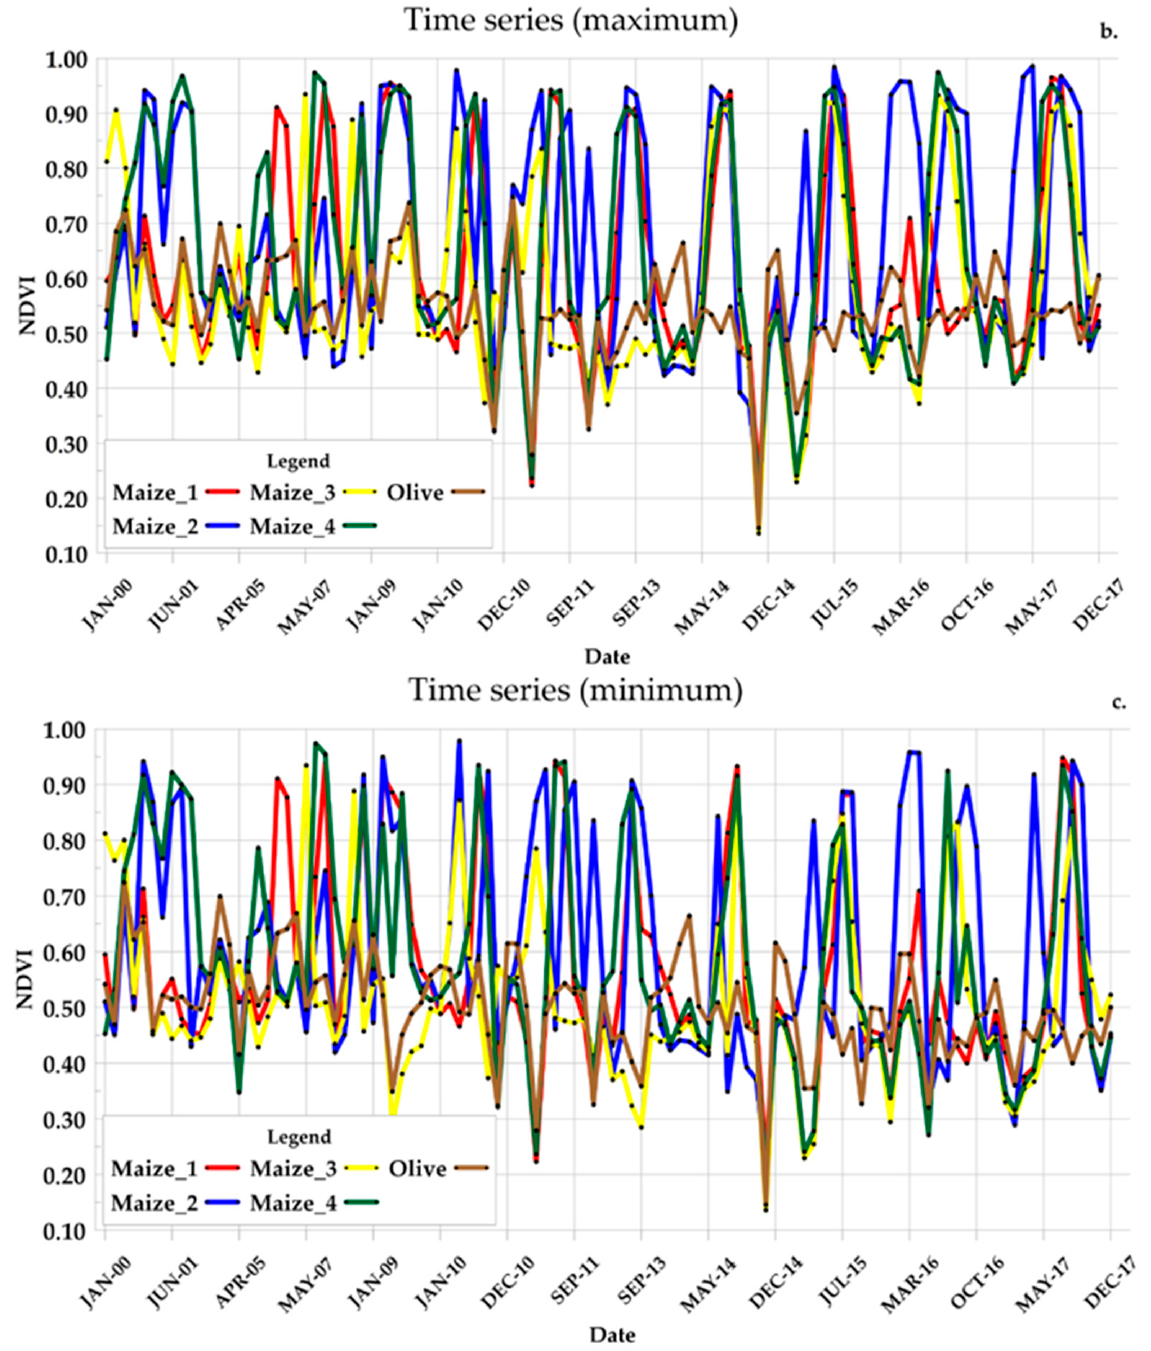
Figure 2. Time series obtained by the average values ( a ), maximum values ( b ) and minimum values ( c ) of available data in each month.